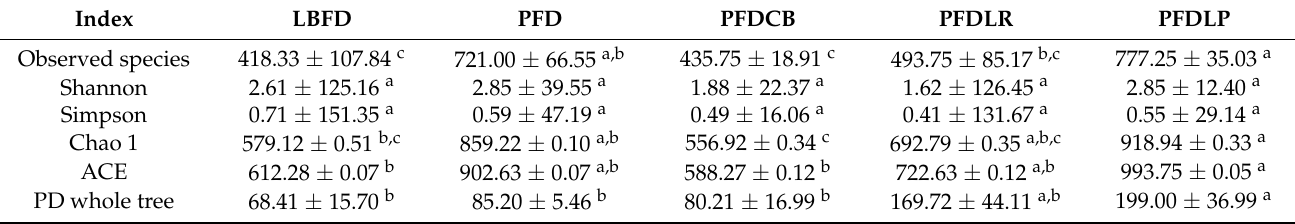
ACE: abundance-based coverage estimator; LBFD, live bait fish feeding group; PFD, pellet-feed feeding group with probiotics free; PFDCB, pellet-feed feeding group with C. butyricum plus; PFDLR, pellet-feed feeding group with L. rhamnosus plus; PFDLP, pellet-feed feeding group with L. plantarum plus. The numbers represent the mean ± SEM ( n = 3). A value followed by a lowercase superscript (a–c) differs significantly from all other values not followed by the same lowercase superscript at the same time point based on ANOVA followed by the post hoc test ( p <